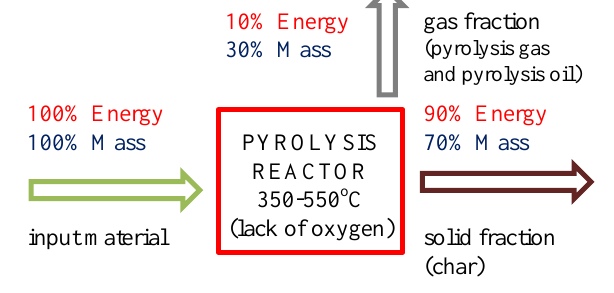
Fig. 1. Mass and energy distribution in pyrolysis